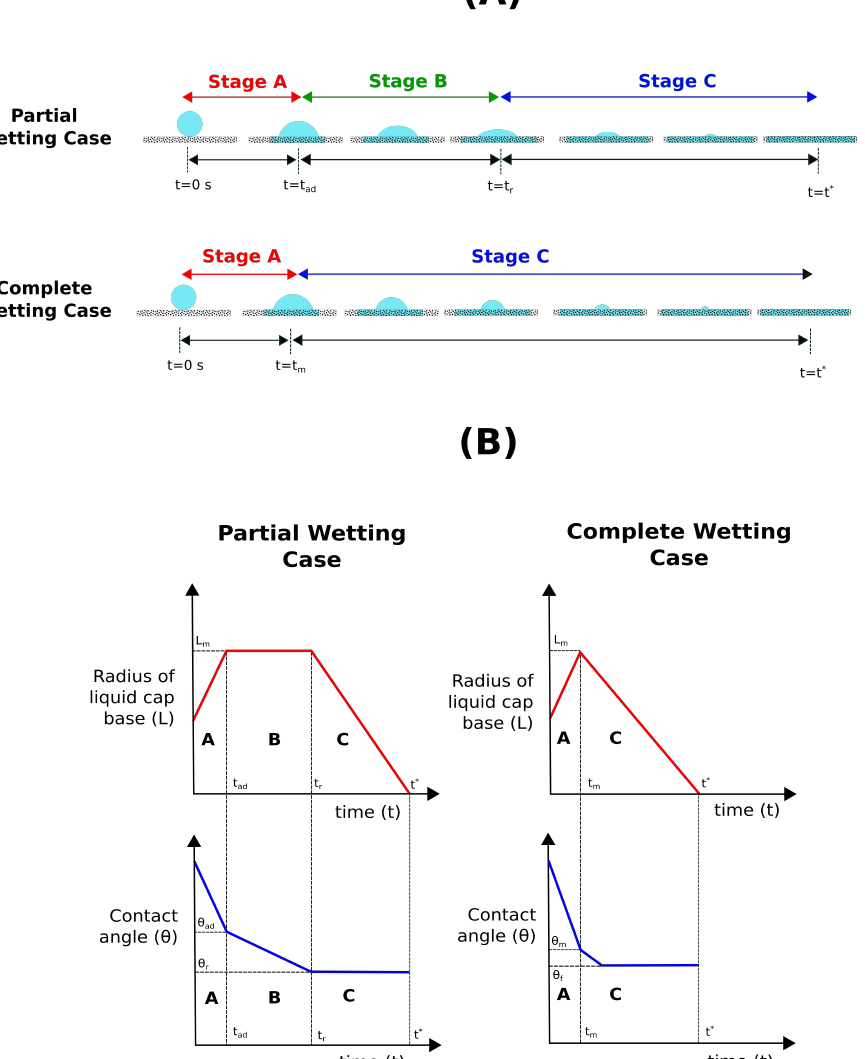
Figure 3. ( A ) Schematic representation of different stages of the droplet spreading and imbibition for the partial wetting case and for the complete wetting case. ( B ) Characteristic trends in variation of the spreading parameters, L (liquid cap base radius) and θ (contact angle) in the cases of partial (left) and complete (right) wetting during the primary spreading